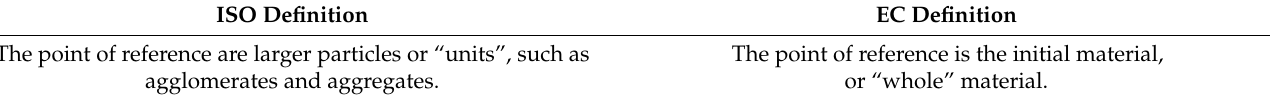
Table 1. Comparison of the essential elements of the ISO and EC definitions for the term “con- stituent